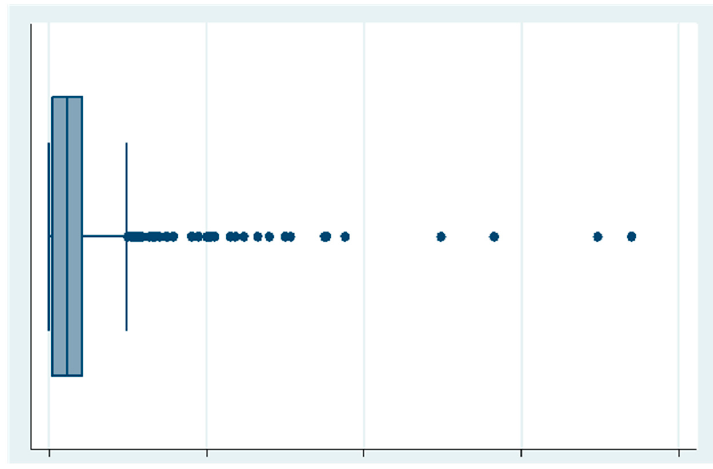
Figure 2. Distribution of OOPEs (Mean: PPP US $70.2 ± 123.7; limits: PPP US $0.00 to PPP US $801.73).